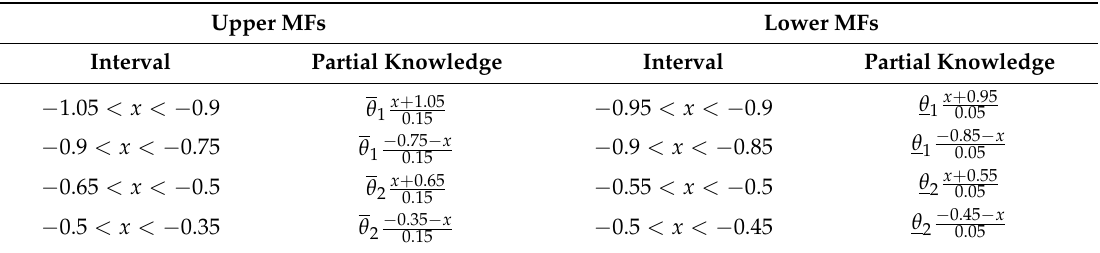
Table 3. Output MF